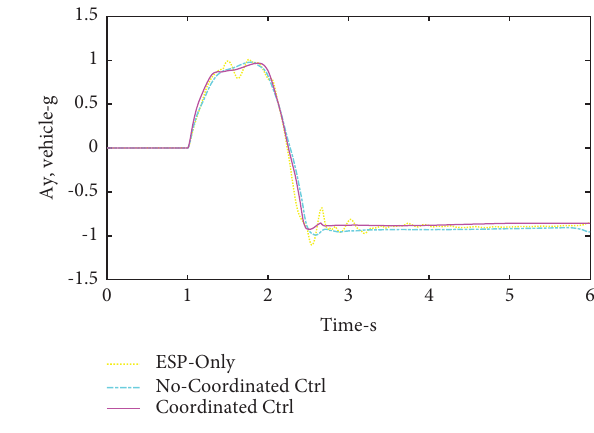
Figure 9: Curve of Ay versus time.